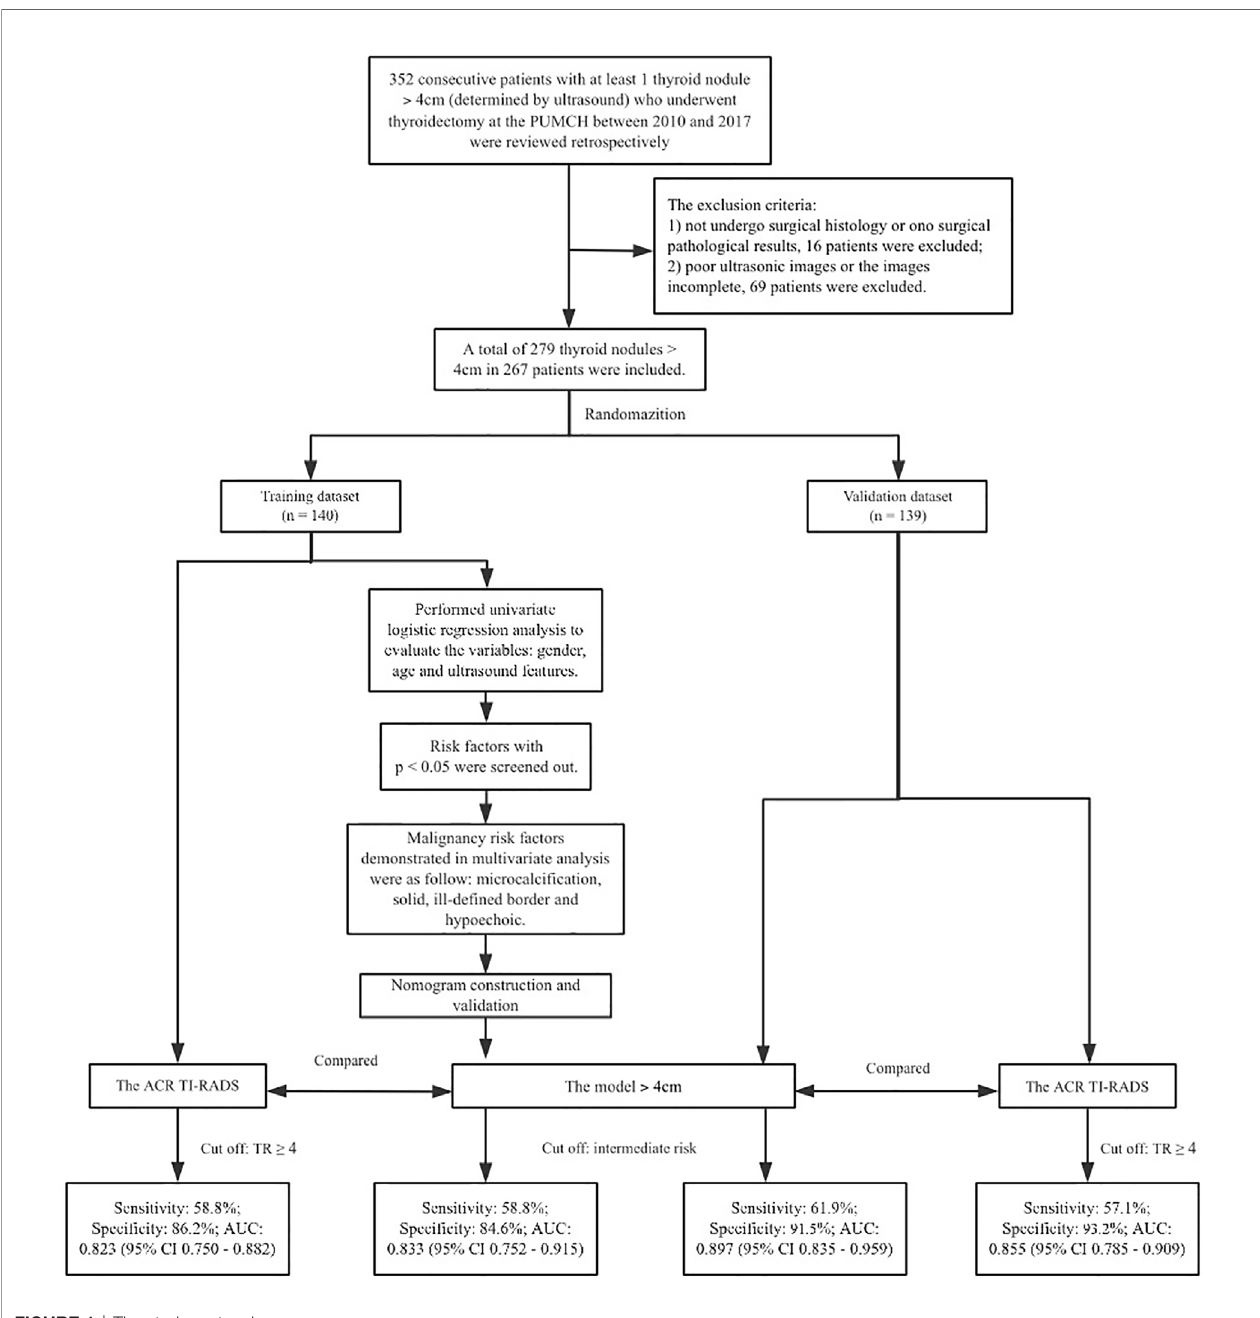
FIGURE 1 | The study